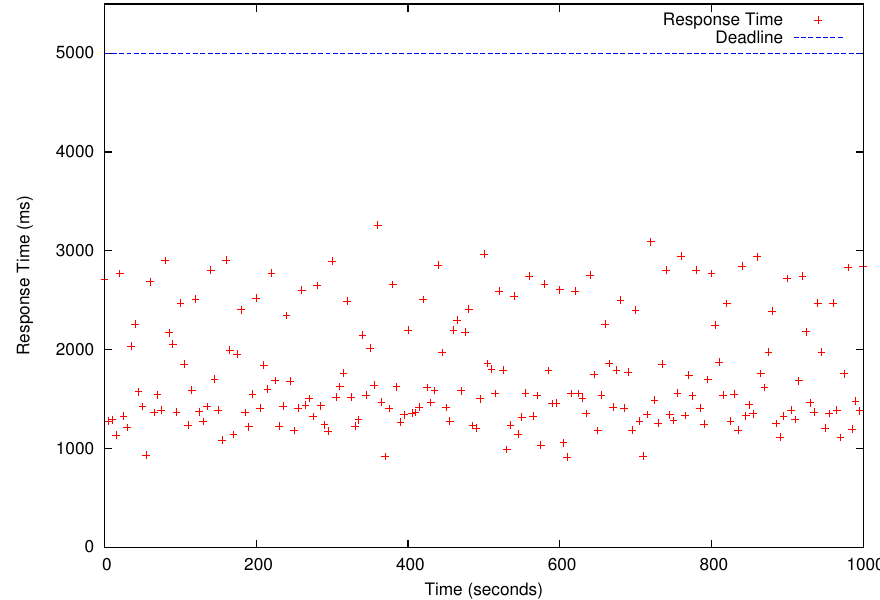
Figure 11. Response Times of K-Means (KM) Jobs. The blue horizontal bar is the deadline (5 s). Each red dot shows the response time of one periodic KM